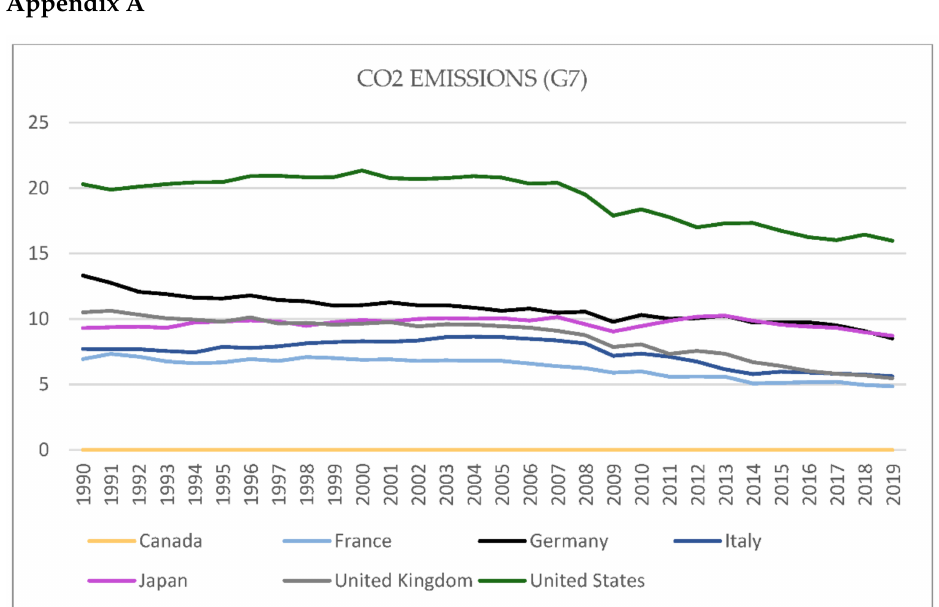
Figure A1. CO 2 emissions for G7 countries. Source: Global Carbon Project.